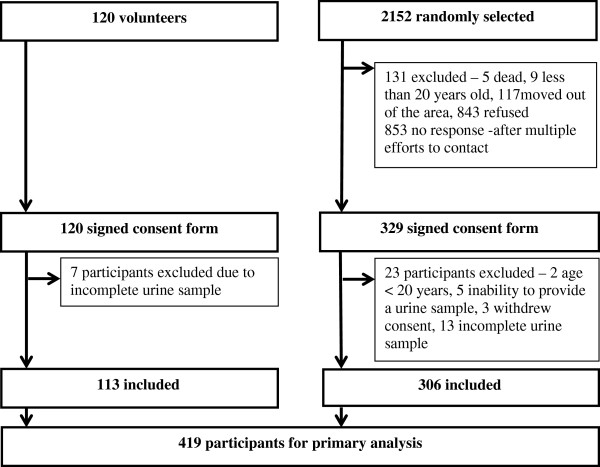
Recruitment of population sample.